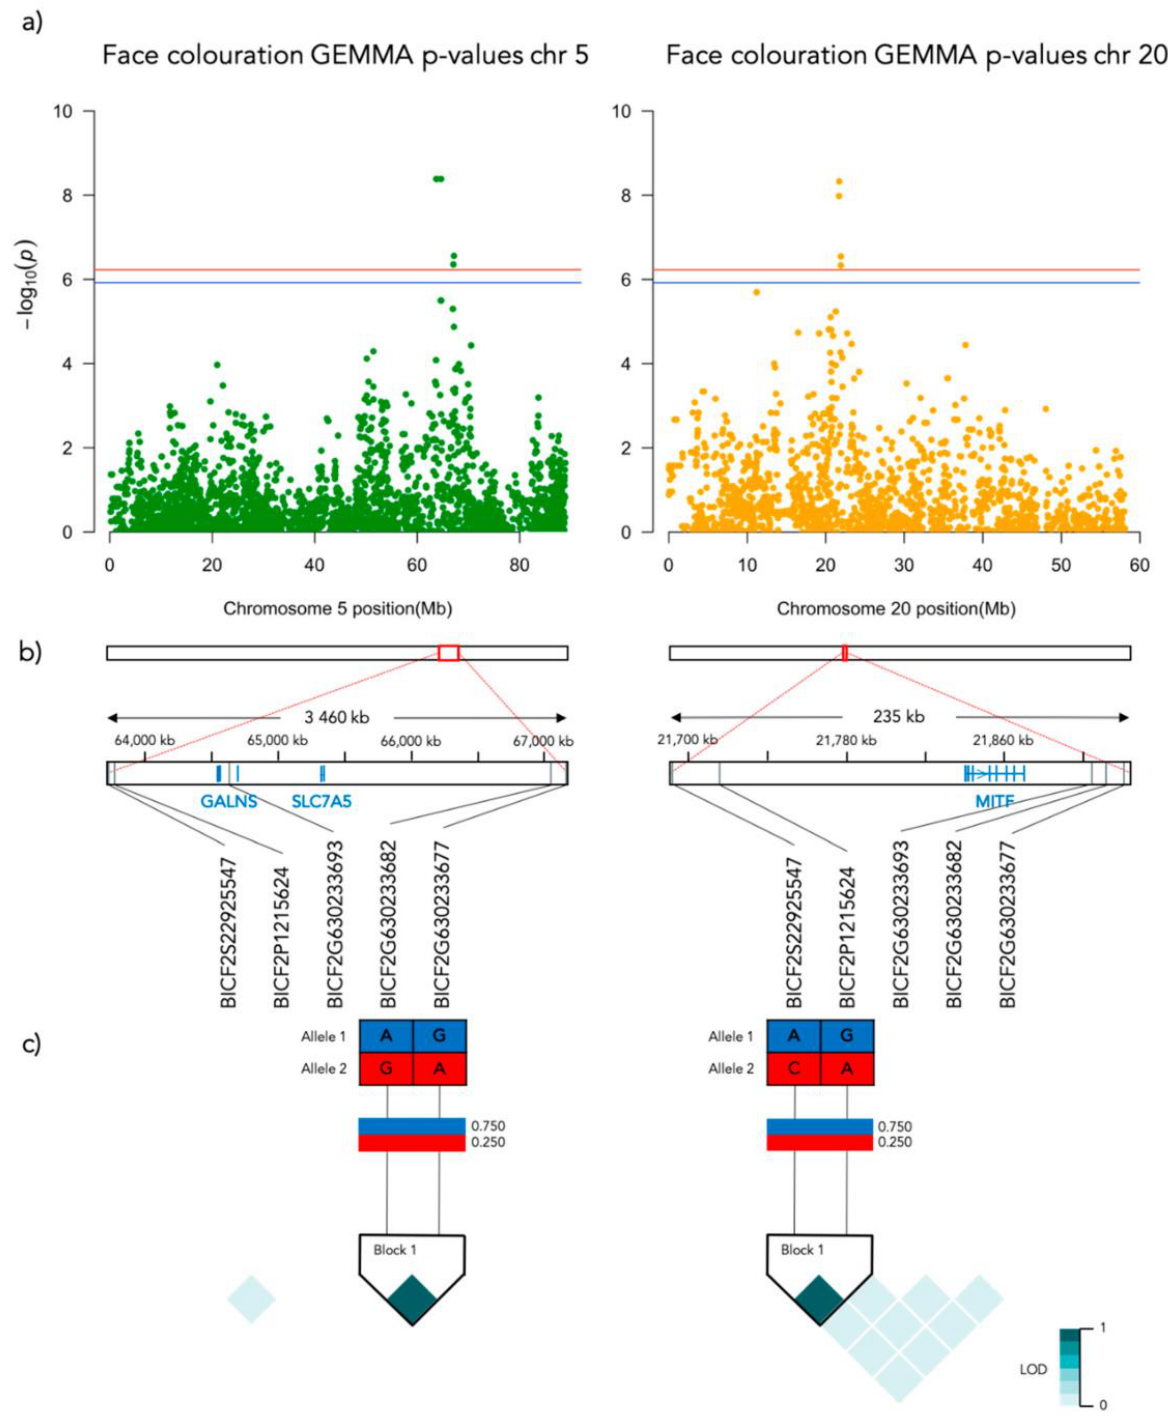
Figure 4. Results from the Genome-Wide Association analysis on the face coloration phenotype for chromosome 5 (left) and 20 (right). ( a ) Manhattan plot of the chromosomes with significantly associated markers. The red line represents genome-wide significance of Bonferroni 5% and the blue 10%. ( b ) (upper) A schematic figure of the size and positioning of the significant region on the chromosome. (lower) Zoomed figure of the associated region showing the positioning of the significant SNP markers in grey and genes in blue. ( c ) Linkage disequilibrium heat map and haplotype blocks of the significant